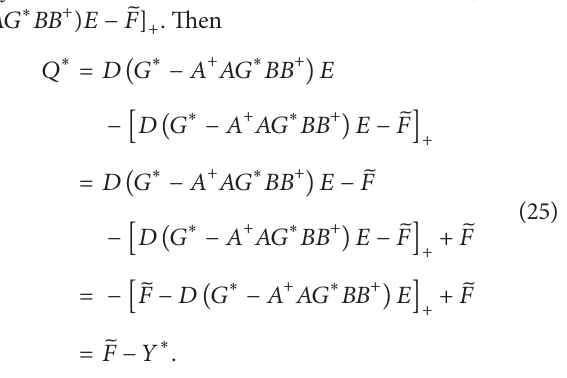
Algorithm 8 (an iteration method for